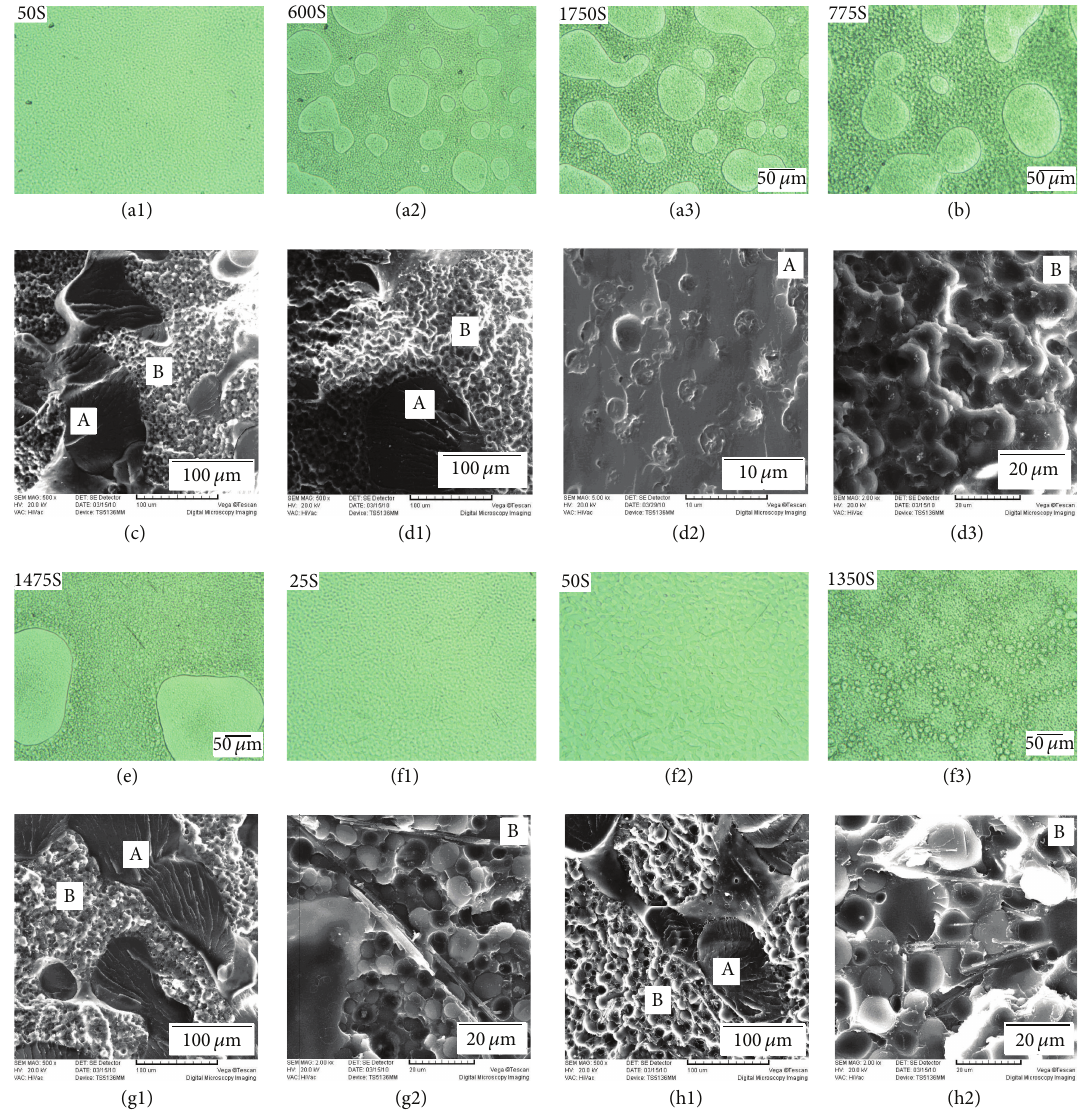
Figure 3: Development of morphologies of the PES-14.3 blends with filler followed by OM and SEM micrographs of the fracture surface of these blends with filler. (a1)–(a3) PES-14.3-A by OM at 120 ∘ C; (b) finial morphology of PES-14.3-A by OM at 140 ∘ C; (c) PES-14.3-A by SEM at 120 ∘ C for 5 h; (d1)–(d3) PES-14.3-A by SEM at 140 ∘ C for 5h; (e) finial morphology of PES-14.3-Ca by OM at 120 ∘ C; (f1)–(f3) PES-14.3-Ca